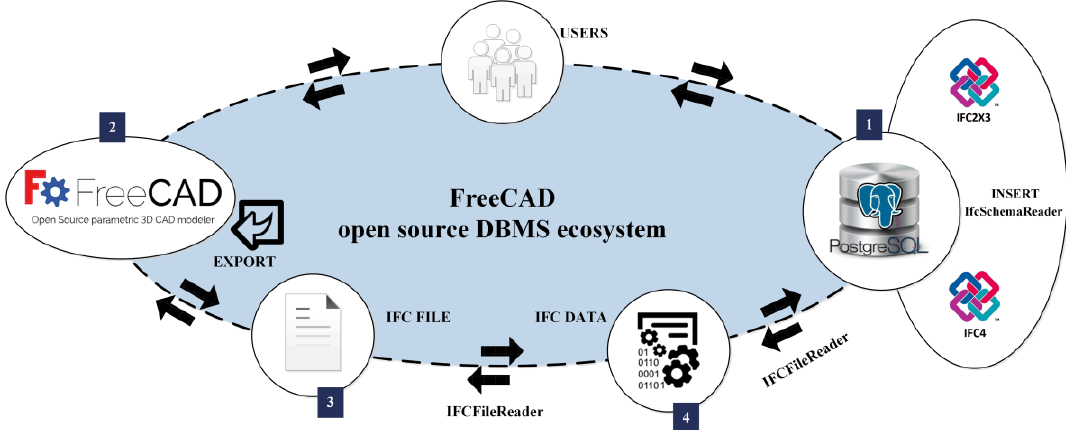
Figure 6: Workflow chart for FreeCAD open source DBMS